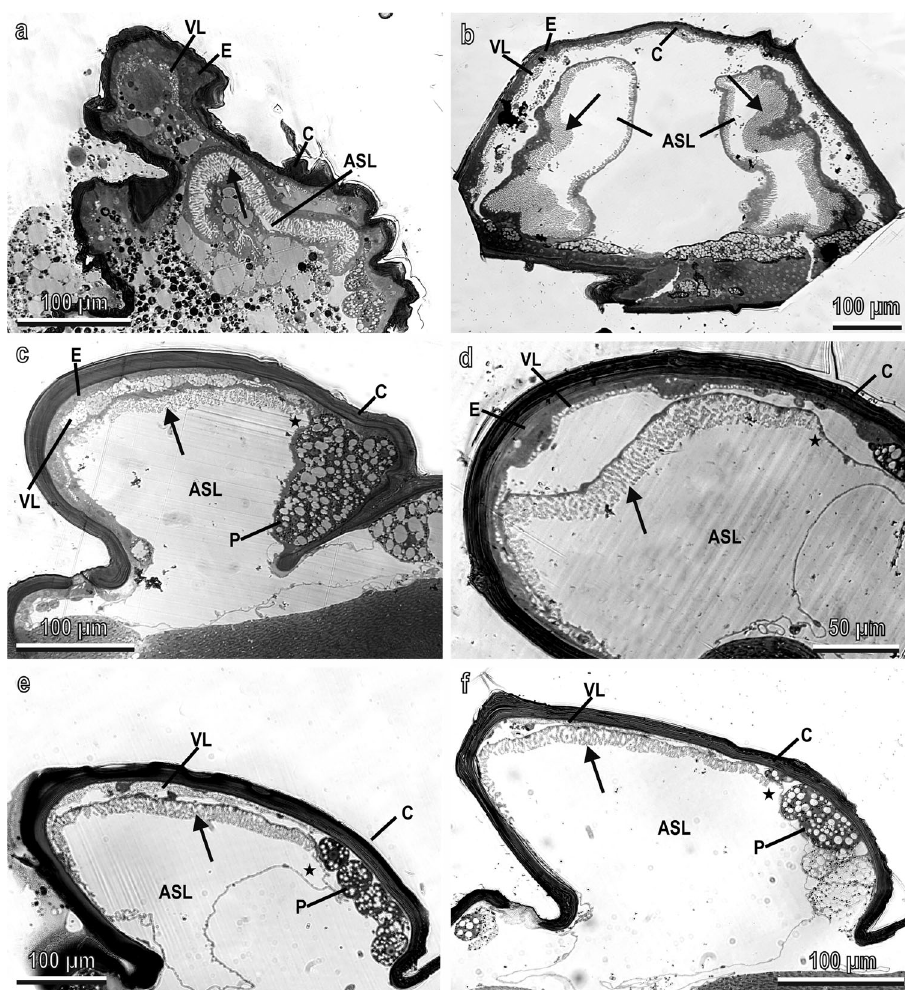
Fig. 3 Semithin sections of the scutellum of Bactrocera oleae . a Scutellum in the pharate adult. Longitudinal section showing an air sac still compressed and reduced in its lumen (ASL); b Scutellum in the just emerged adult. Frontal section showing the two air sacs with their lumen (ASL) which begin to in fl ate increasing in size. Note the central empty space still present under the transparent cuticle (C); c – f Scutellum in the female three days after emergence ( c ) and ten days after emergence ( e ) and in the male three days after emergence ( d ) and ten days after emergence ( f ). Longitudinal sections showing one of the two air sacs fully developed under the transparent cuticle (C). Note that the arborisations of the air sac and the vesicular layer are located just under the transparent cuticle on the dorsal side of the scutellum while they disappear in the pigmented area (P). Asterisk points out the transition between the arborisations with the vesicular layer and the pigmented area; Arrow points out the arborisations; ASL air sac lumen, C cuticle, E epidermis, P pigmented area, VL vesicular